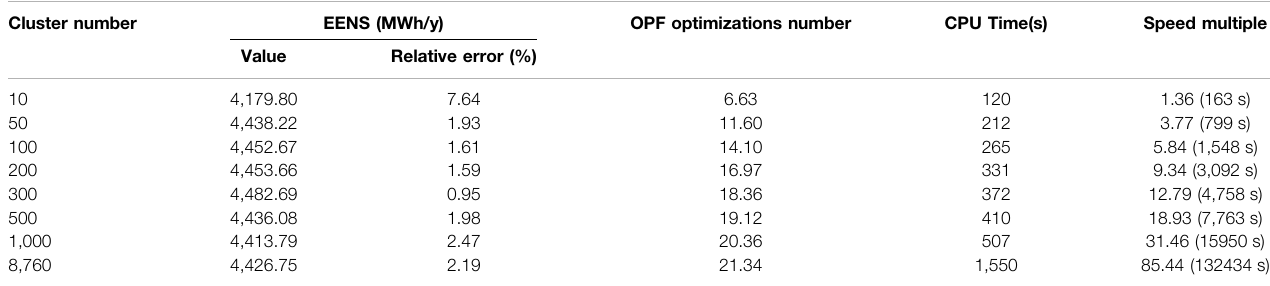
TABLE 2 | The Impact of Cluster Number on Reliability assessment results (RTS-79).